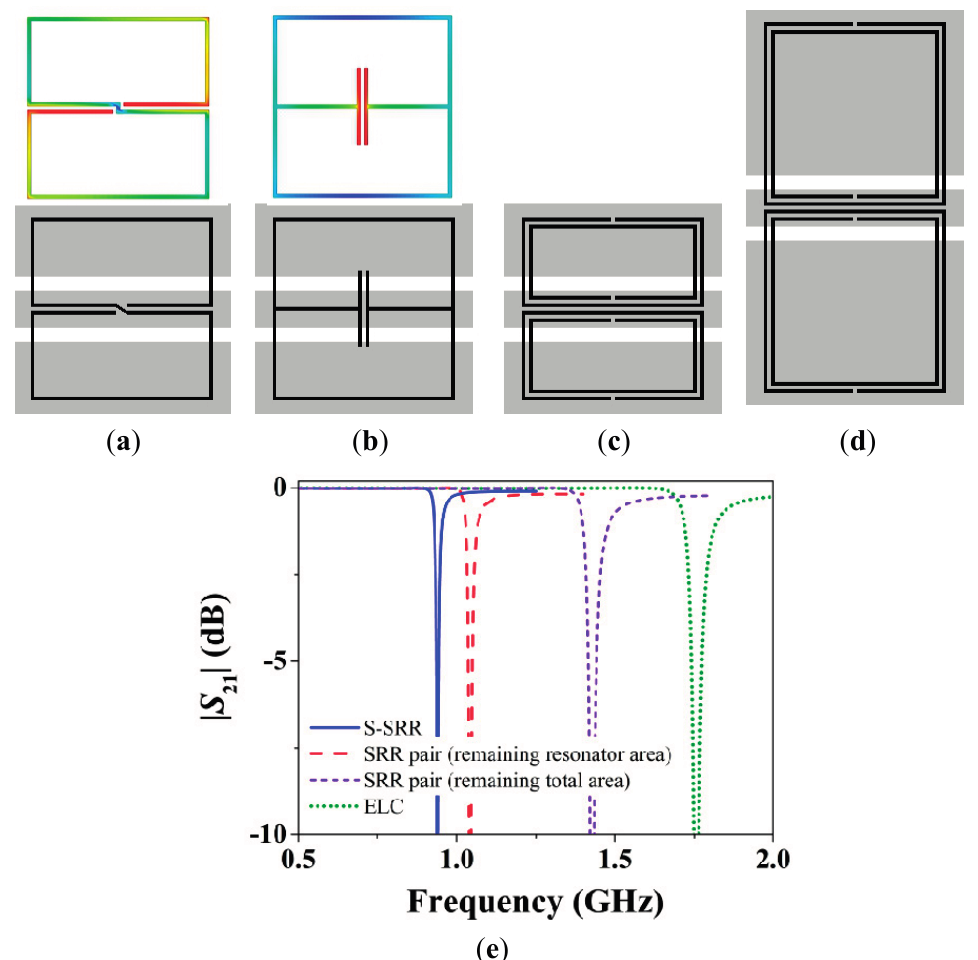
Figure 3. Miniaturization comparison between S-SRRs, ELCs, and SRRs. A CPW is loaded with ( a ) an S-SRR; ( b ) an ELC; ( c ) a pair of SRRs keeping the same total area; and ( d ) a pair of SRRs keeping the same resonator area; ( e ) Magnitude of the lossless transmission coefficient. In (a) and (b) the electric field distributions at the fundamental resonance are